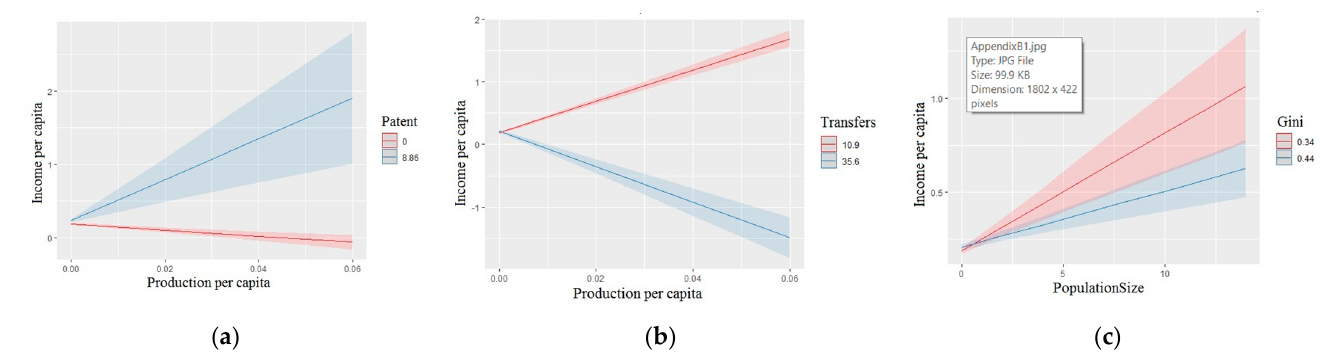
Figure A1. Marginal effects of interaction terms from model 4i where income per capita is the dependent variable: ( a ) production per capita is an independent variable at municipal level, while the Patent is a grouping factor at regional level; ( b ) production per capita is an independent variable at municipal level, while the Transfers is a grouping factor at regional level; ( c ) population size is independent variable at municipal scale, and Gini coefficient is a grouping factor at regional level. Minimum and maximum values (lower and upper bounds) of the moderator are used to plot the interaction.